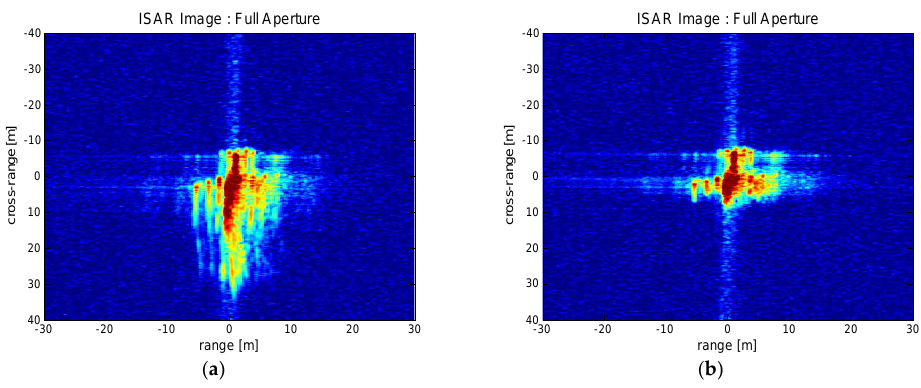
Figure 18. Processed high resolution ISAR image (Cessna 208): ( a ) Initial ISAR processing result; ( b ) After Doppler history based MOCO.